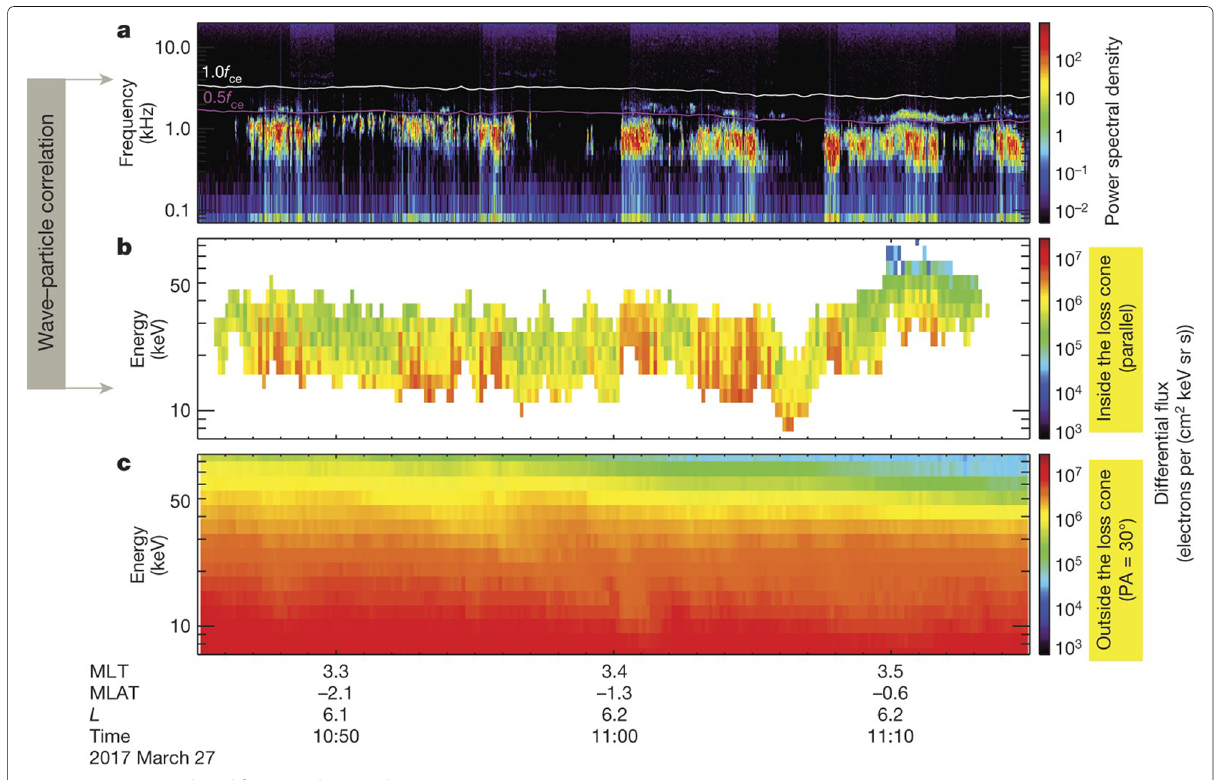
Fig. 16 Figure reproduced from Kasahara et al. (2018)